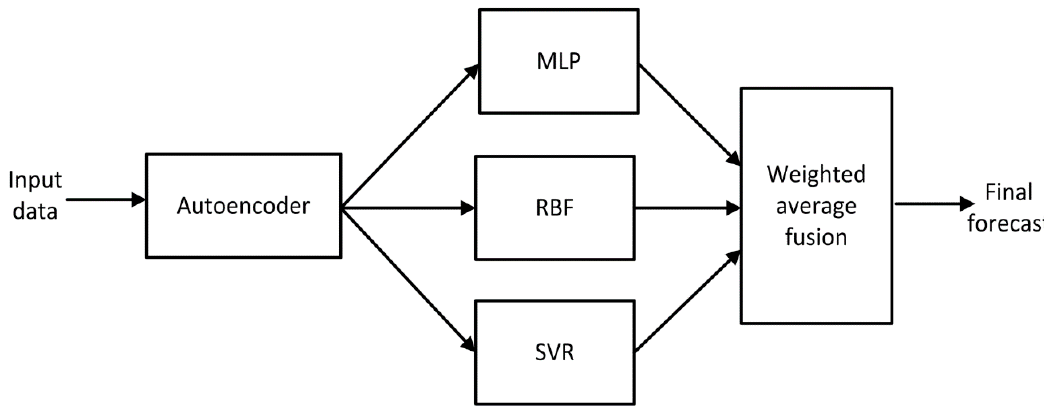
Figure 4. The autoencoder based ensemble system in forecasting the 24-h power demand for the seven days of the next week. Input data is composed of 170-element vectors representing the data of the previous week. The size of these vectors is reduced by an autoencoder to the value dictated by the size of the last hidden layer of it. The output vectors of the autoencoder form the diagnostic features for three solutions of predictors: Neural networks (MLP, RBF) and support vector machine in regression mode, called SVR, which generate the final forecast representing predictions of load demand for the seven days in the next week. The last block performs a fusion of the predicted loads for the particular 24 h of the days within this week.